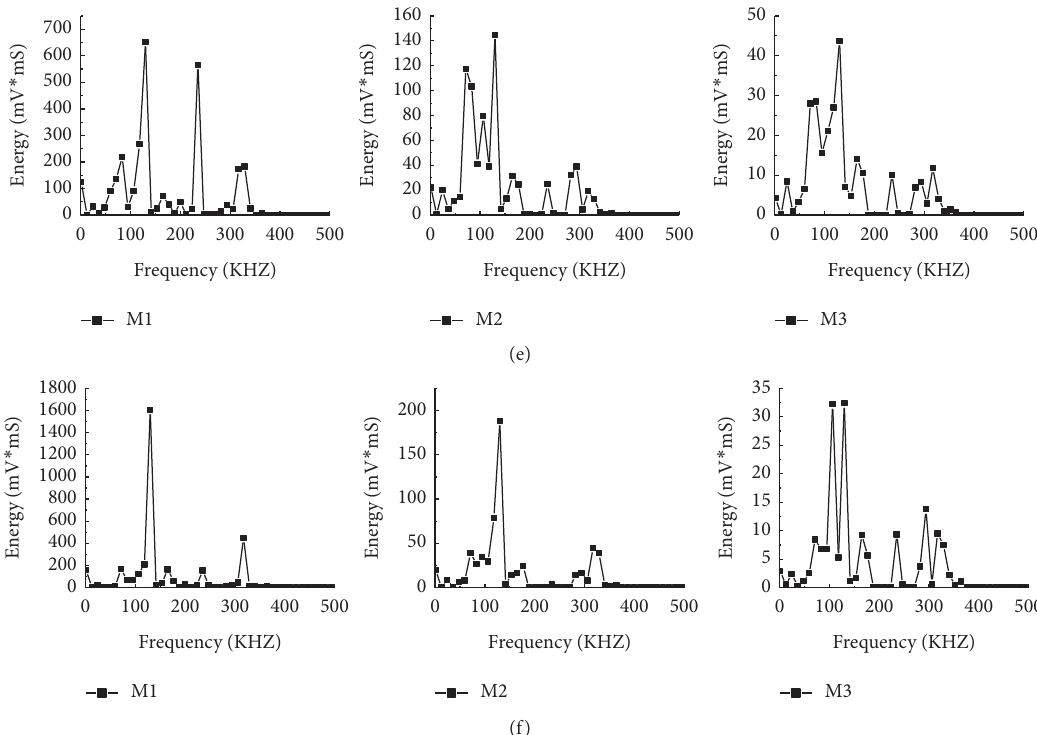
Figure 12: The energy distribution of acoustic emission signal frequency band of plate-shaped rock. (a) G3761-L (00). (b) G3761-L (450). (c) G3761-L (900). (d) GAM-L (00). (e) GAM-L (450). (f) GAM-L